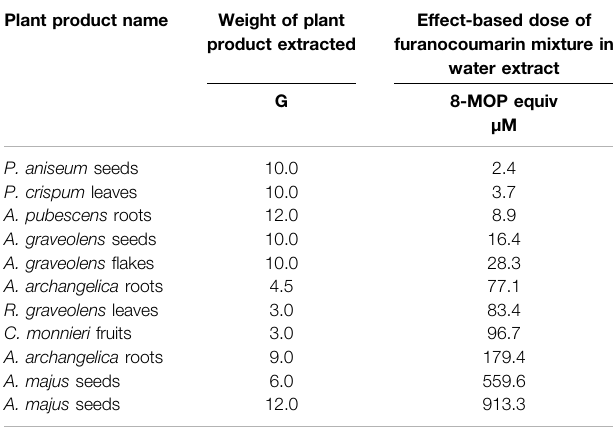
TABLE 2 | The effect-based dose measures of furanocoumarin mixtures in ARFP